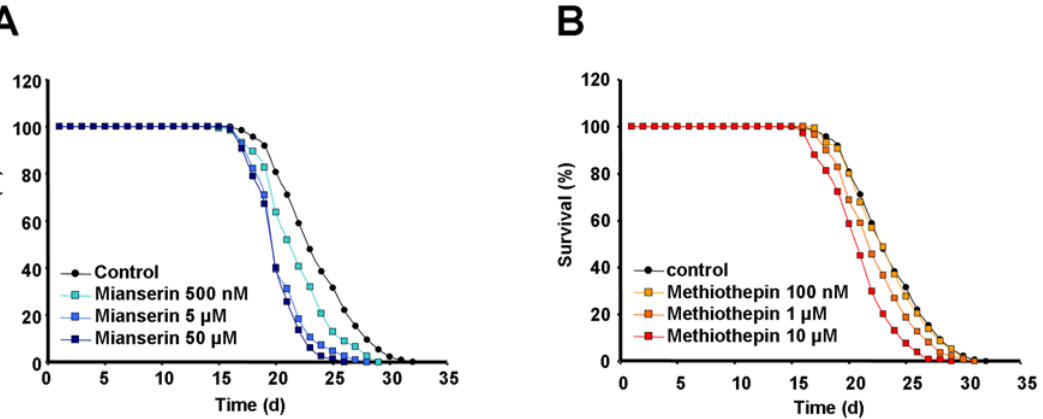
Figure 1. Antidepressants of the human serotonin antagonist type do not extend Caenorhabditiselegans lifespan. Panel A: The antidepressant mianserin shortens C.elegans lifespan at concentrations of 50 m M (dark blue boxes; this concentration was shown extend lifespan in the original publication [ref. 24]), 5 m M (medium blue boxes), and 500 nM (light blue boxes). Untreated control nematodes are depicted by black circles. Panel B: The chemically and functionally related compound methiothepin similarly shortens C.elegans lifespan at concentrations of 10 m M (red boxes; this concentration was shown extend lifespan in the original publication [ref. 24]), 1 m M (orange boxes), and has no significant effect on lifespan at a lower concentration of 100 nM (yellow boxes). Untreated control nematodes are depicted by black circles.